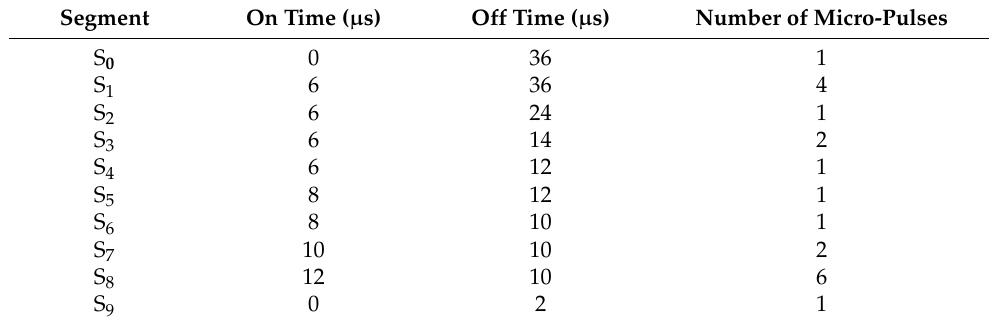
Figure 2. Micro-pulse train waveform (blue bars) and segments designed based on the pulse-on times and pulse-off times for the micro-pulses summarized in Table 1. The pulsed power is output based on the micro-pulse train waveform. Table 1. Summary of on time and off time for segments in the micro-pulse train used in the present